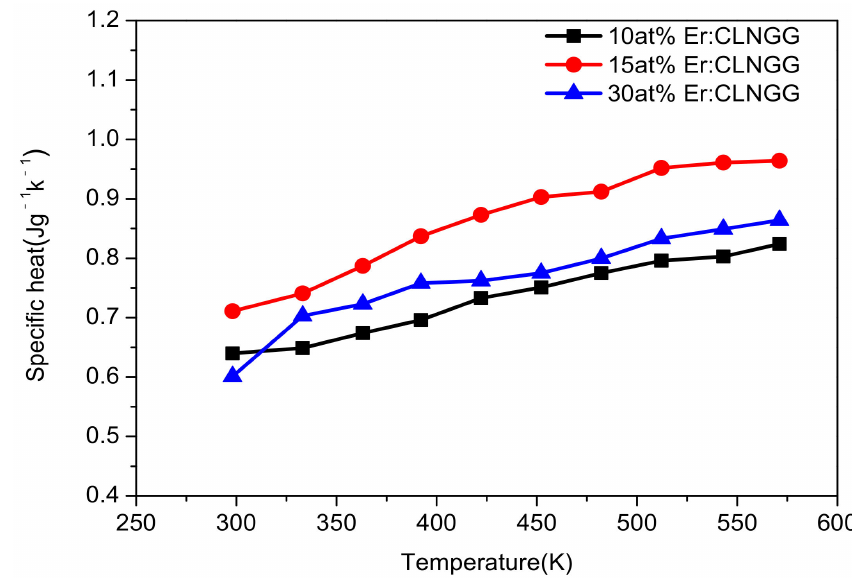
Figure 5. Specific heat of Er:CLNGG crystal as a function of temperature.